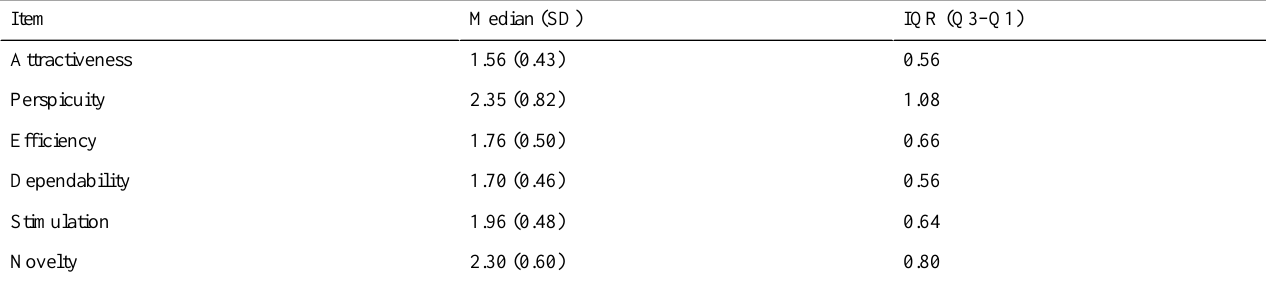
Table 1. Results of the User Experience Questionnaire completed by patients